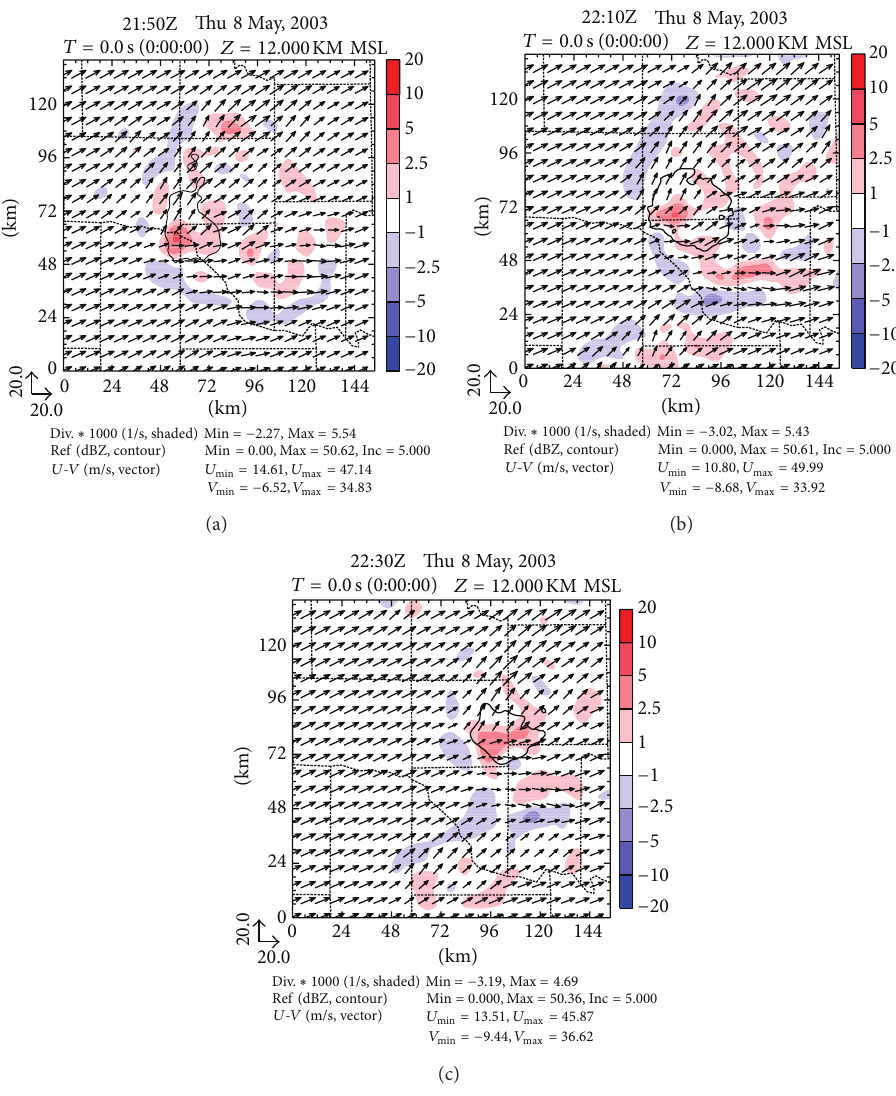
Figure 7: Same as Figure 6 (horizontal divergence, 10 −3 s −1 ) but for 12km height and 20-minute intervals.